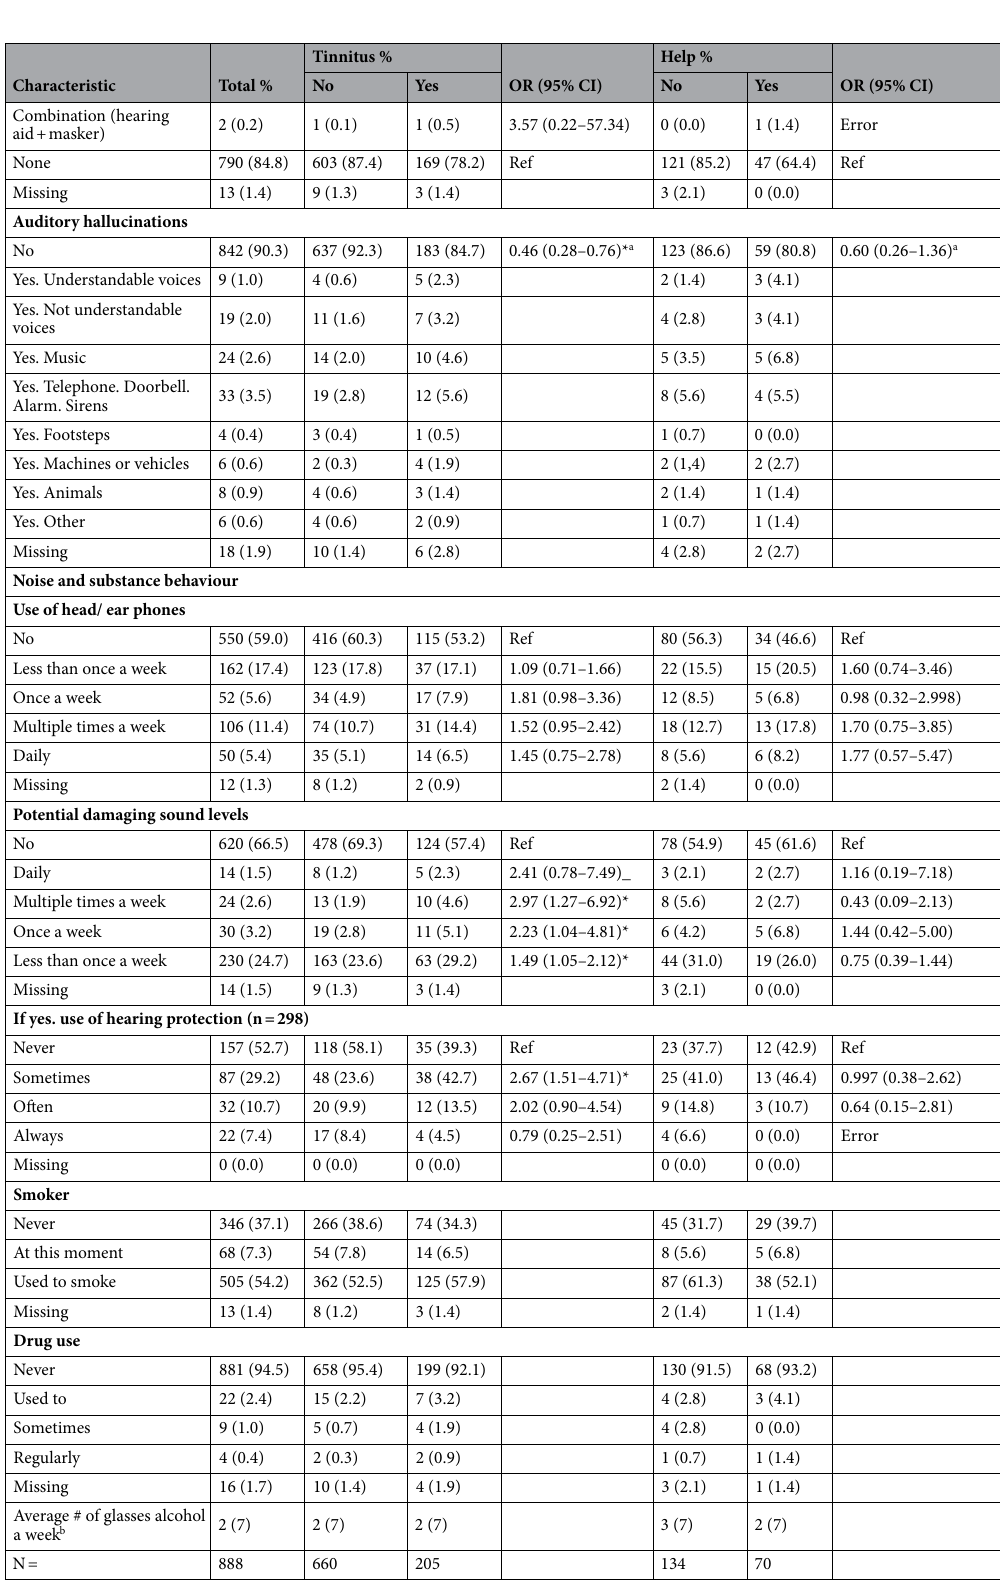
Table 4. Characteristics on general health, psychological health, audiological characteristics and noise and substance behaviour. Please see Supplementary Table S2 for answer to auditory hallucinations, other. a Reference is yes. b Median (IQR) * p < 0.05. c Hearing problem for which hearing aids were used before 60th year of